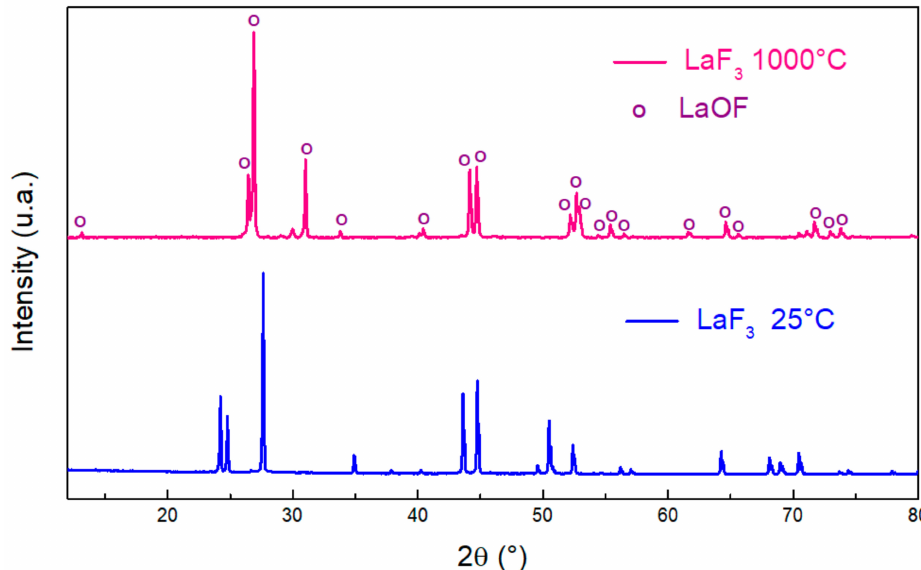
Figure 3. XRD patterns of LaF 3 before (blue) and after (pink) thermal treatment at 1000 ◦ C. On the other hand, the peaks present in the XRD pattern of the sample after thermal treatment of LaF 3 in a furnace at 1500 ◦ C correspond mainly to the known peaks of La 2 O 3 (red pattern in Figure 4) [24]. However, some peaks do not correspond to the La 2 O 3 structure. To puzzle out this problem and better understand the origin of these peaks, our sample was studied by XRD a week after its thermal treatment, and the same XRD pattern appears. We then performed the XRD of the same sample after 4 weeks. The obtained pattern shows a structure very close to that of La(OH) 3 [25] (green pattern in Figure 4). The production of lanthanum hydroxide is due to a reaction, at room temperature, between La 2 O 3 and water from the atmosphere [26,27].